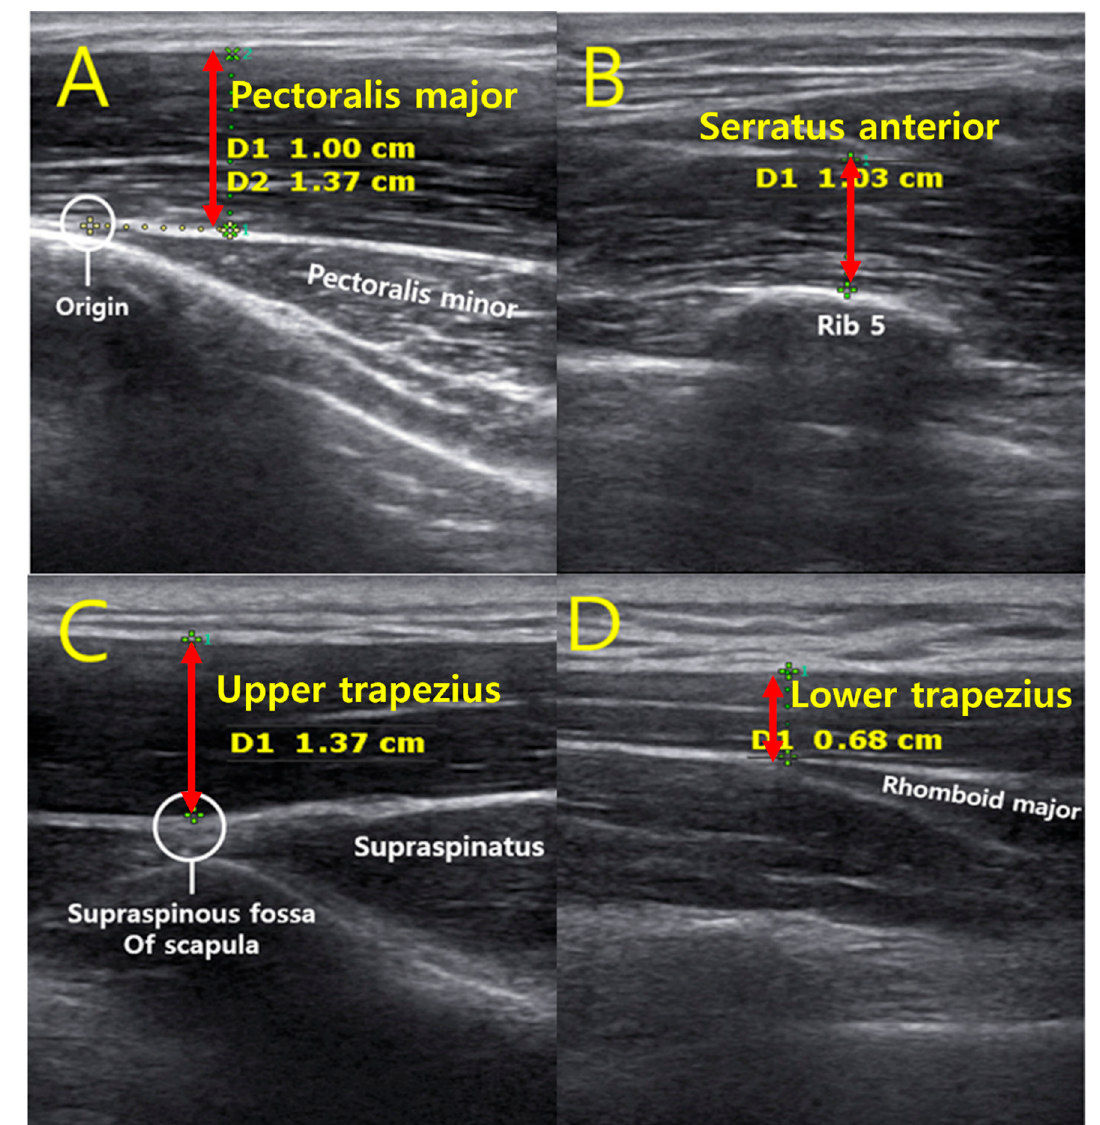
Figure 2. Ultrasound images of the anatomical landmarks and thickness of each muscle; ( A ) Pectoralis major, ( B ) Serratus anterior, ( C ) Upper trapezius, ( D ) Lower trapezius.